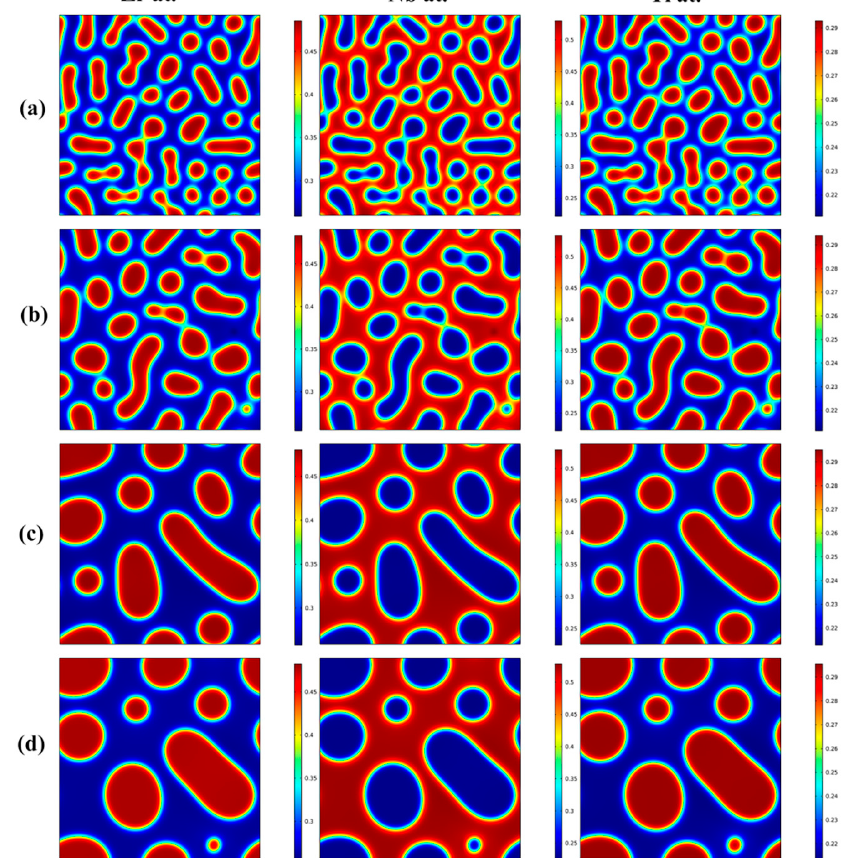
Figure 3. The morphology evolution of the Zr-rich, Nb-rich and Ti-rich phases with aging time increasing for the Zr-40Nb-25Ti alloy aged at 900 K for di ff erent times: ( a ) 50 min, ( b ) 100 min, ( c ) 500 min and ( d ) 1000 min. To more intuitively indicate the change in the size and the volume fraction of the spinodal phases with the aging time increasing, we calculated the diameter and volume fraction of the droplet-like Zr-rich and Ti-rich phases, and the change in the mean